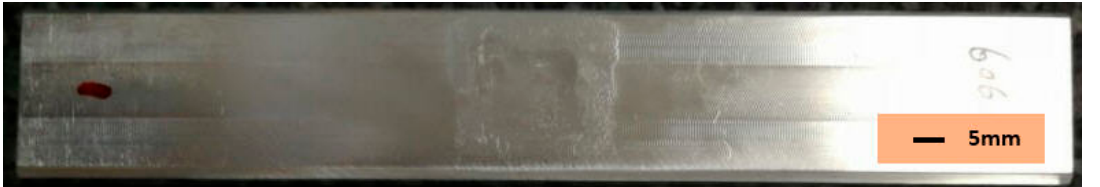
Figure 12. A specimen repaired with a 6061 powder coating.